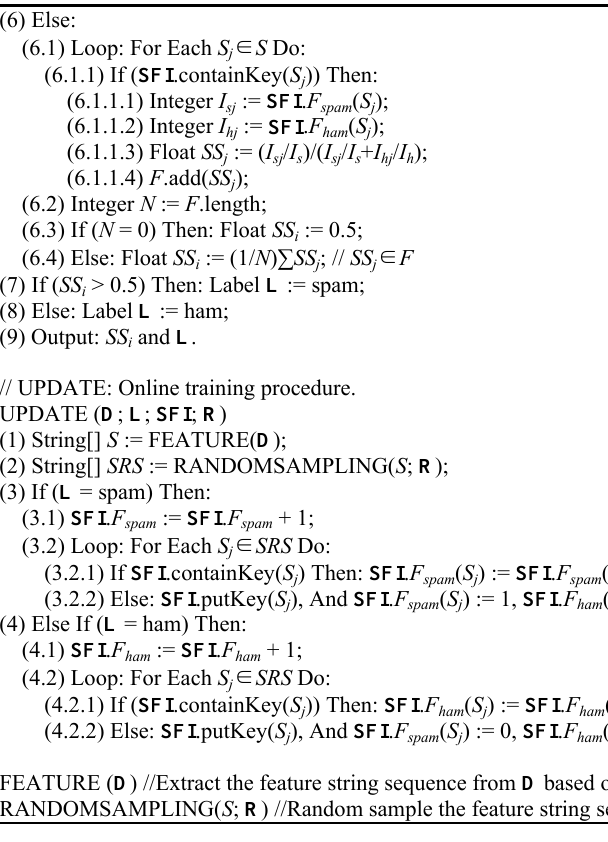
Fig. 4. Pseudo-Code for the SFITC-R